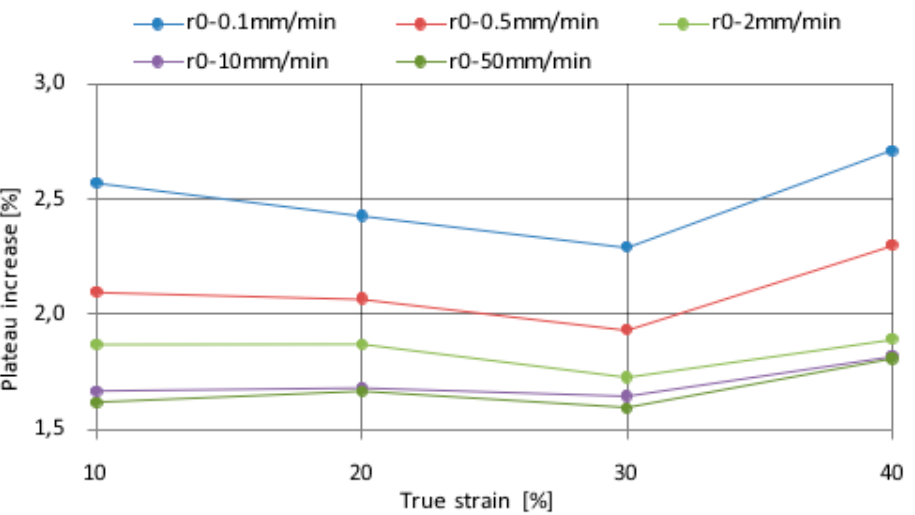
Figure 18. Influence of the unloading duration relatively to the yield plateau for deformations from 10 to 40% for loading speeds from 0.1 to 50 mm/min.